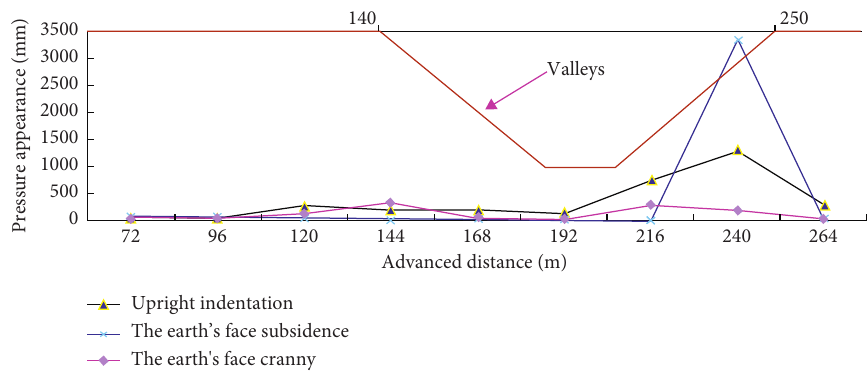
Figure 10: Pressure curve of coal 1 − 2